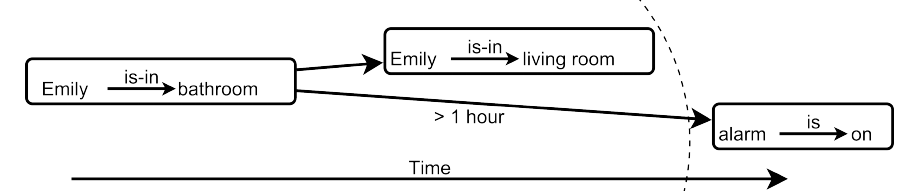
Figure 4. Example of a timeline. The dotted line represents the current moment (“wave”) of